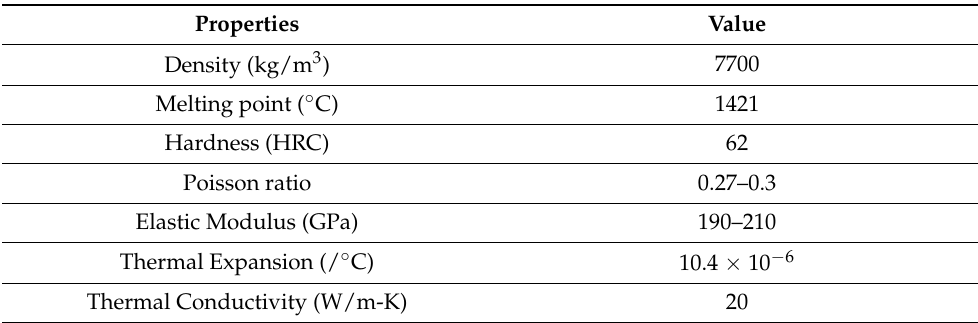
Table 2. Properties of HcHcr steel [38].